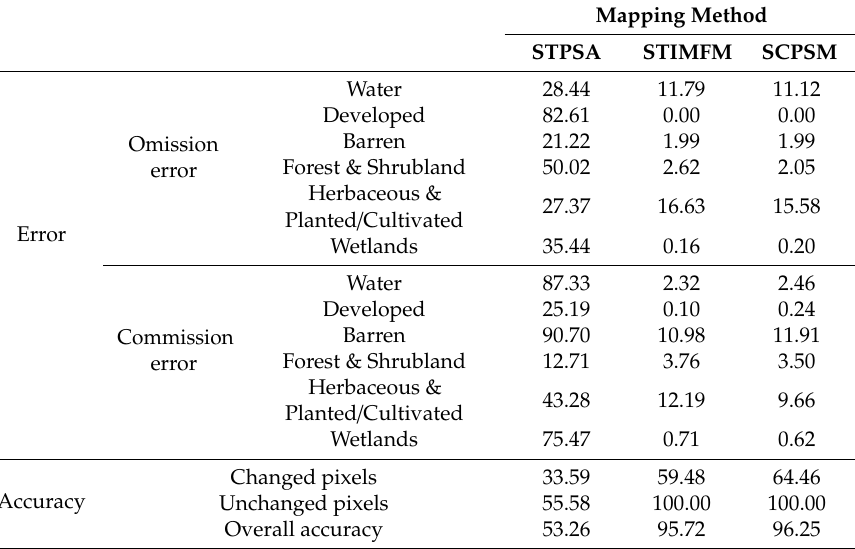
Table 1. The error and accuracies (%) for changed pixels, unchanged pixels, and all pixels (overall accuracy) of di ff erent methods in the NLCD